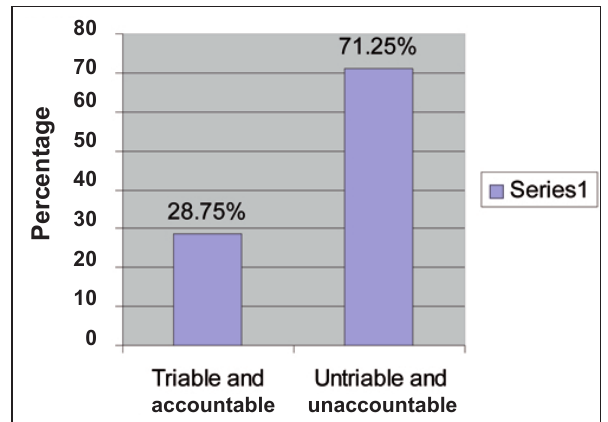
Fig. 5. Findings on triability and/or